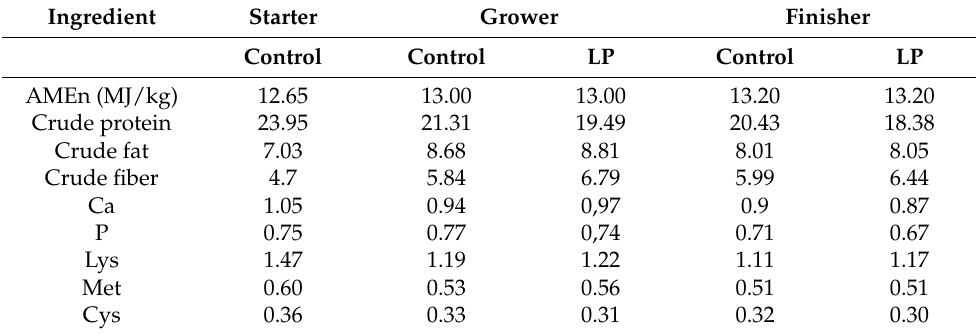
Table 2. Measured nutrient contents of the experimental diets (%). Ingredient Starter